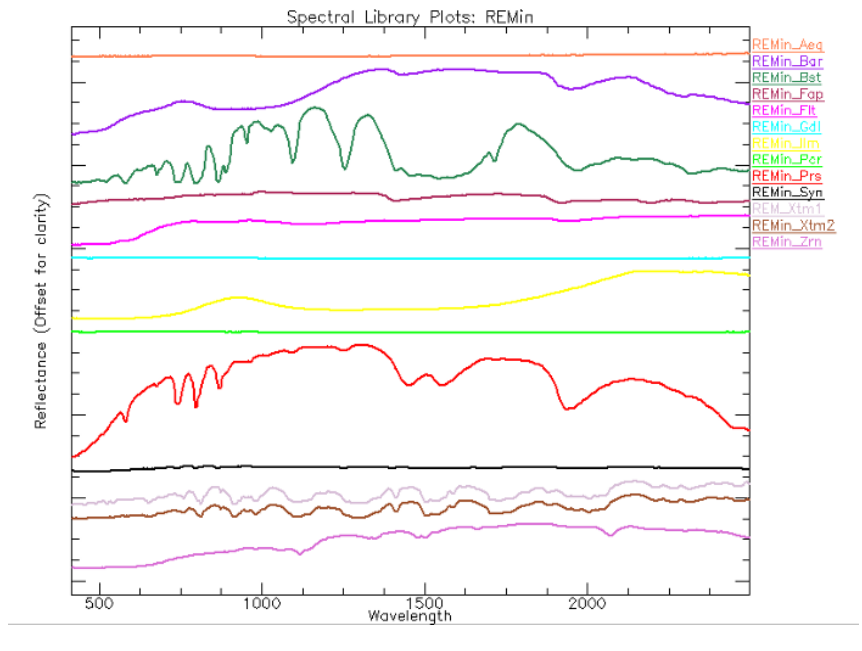
Figure 8. Spectral library plot of the REE -bearing minerals.